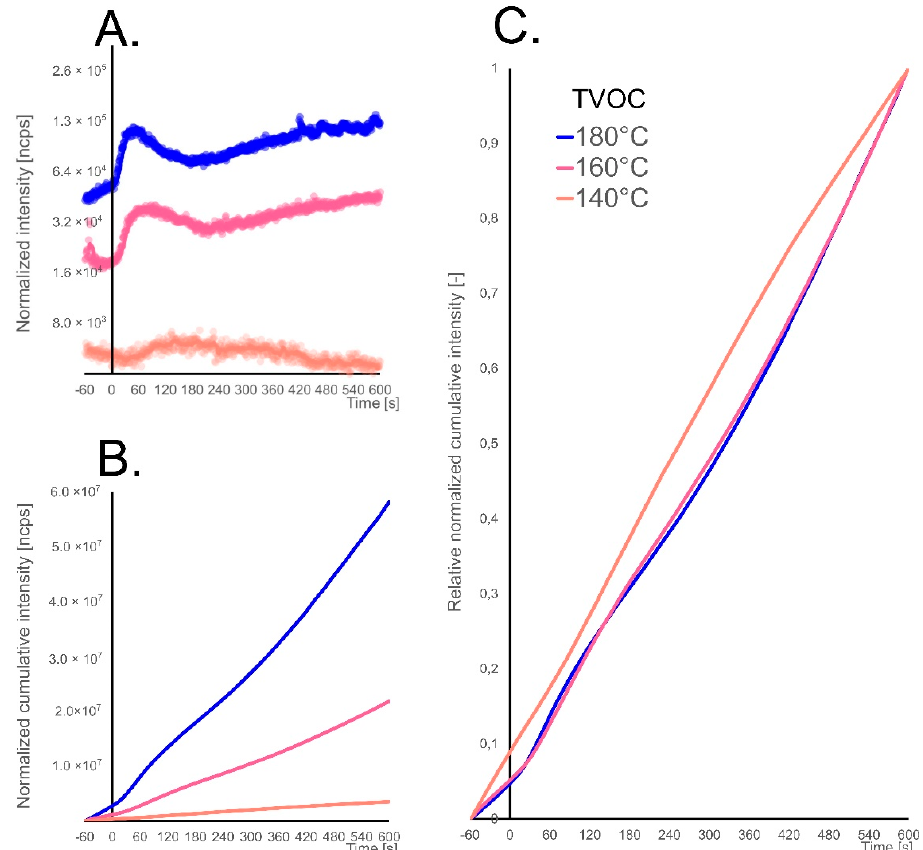
Figure 3. Comparison of emission profile ( A ), cumulative emission ( B ) and relative cumulative emission ( C ) expressed as TVOC (total volatile organic compounds) parameter during potato cube deep-frying in rapeseed oil for different frying temperatures, namely 140 °C, 160 °C and 180 °C; Start of frying at time 0 s.